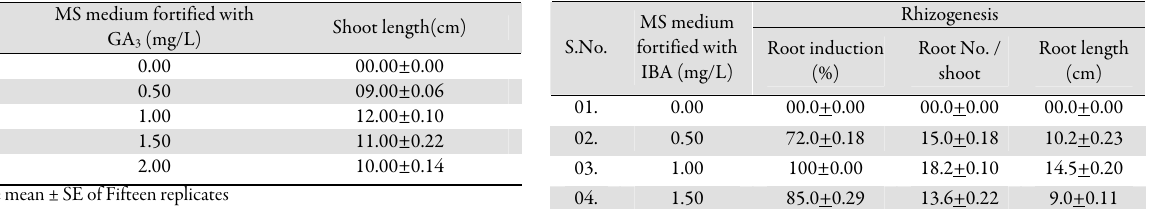
Table 4. Rhizogenesis of elongated shoots of Physalis angulata L. at two weeks of culture